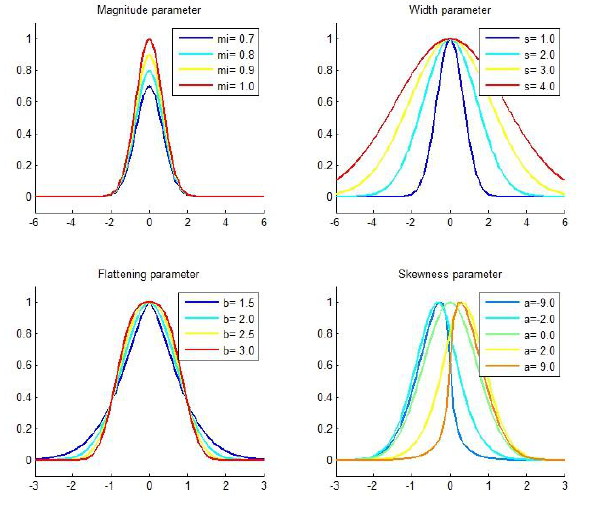
Figure 2: Four parameters of the generalized Gaussian curve